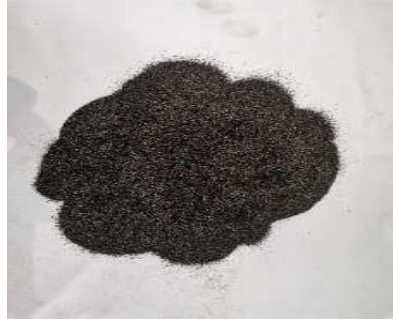
Figure 10. Solid phase particle.